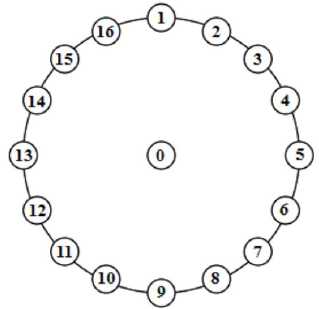
Fig. 3. Wheel topology